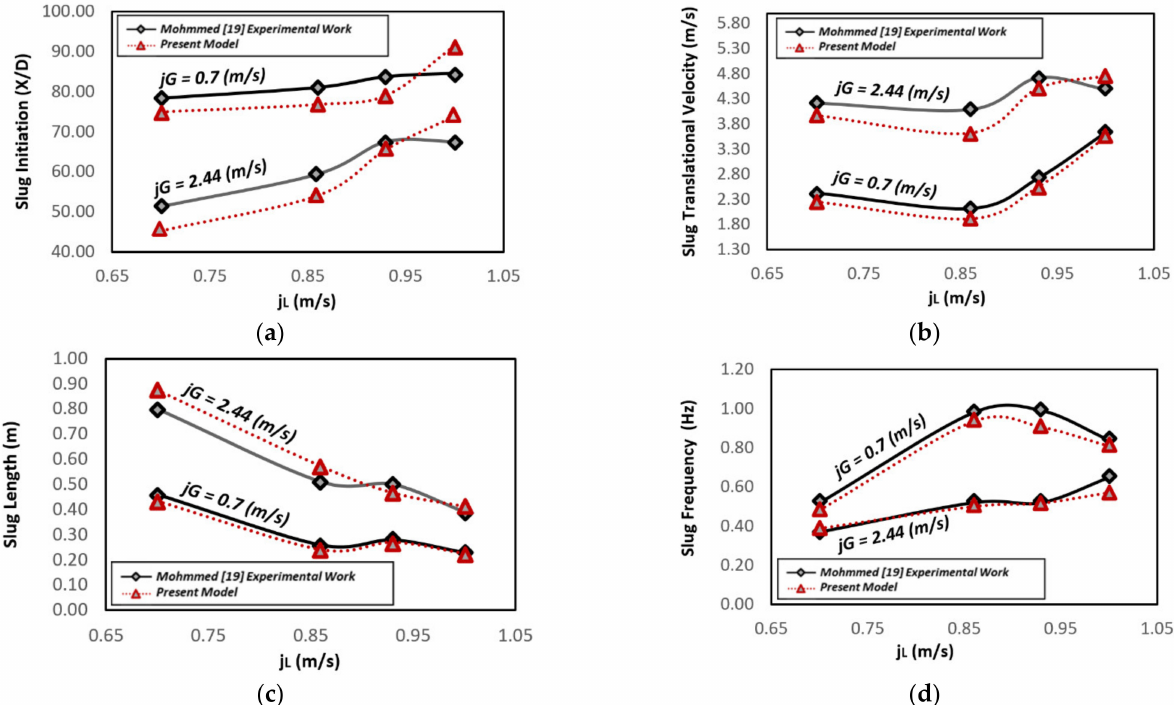
Figure 7. Quantitative validation of air–water two-phase flow in the present model against the experimental work of Mohmmed [19]. Validation of ( a ) slug initiation position; ( b ) slug translational velocity; ( c ) slug liquid length; ( d ) slug